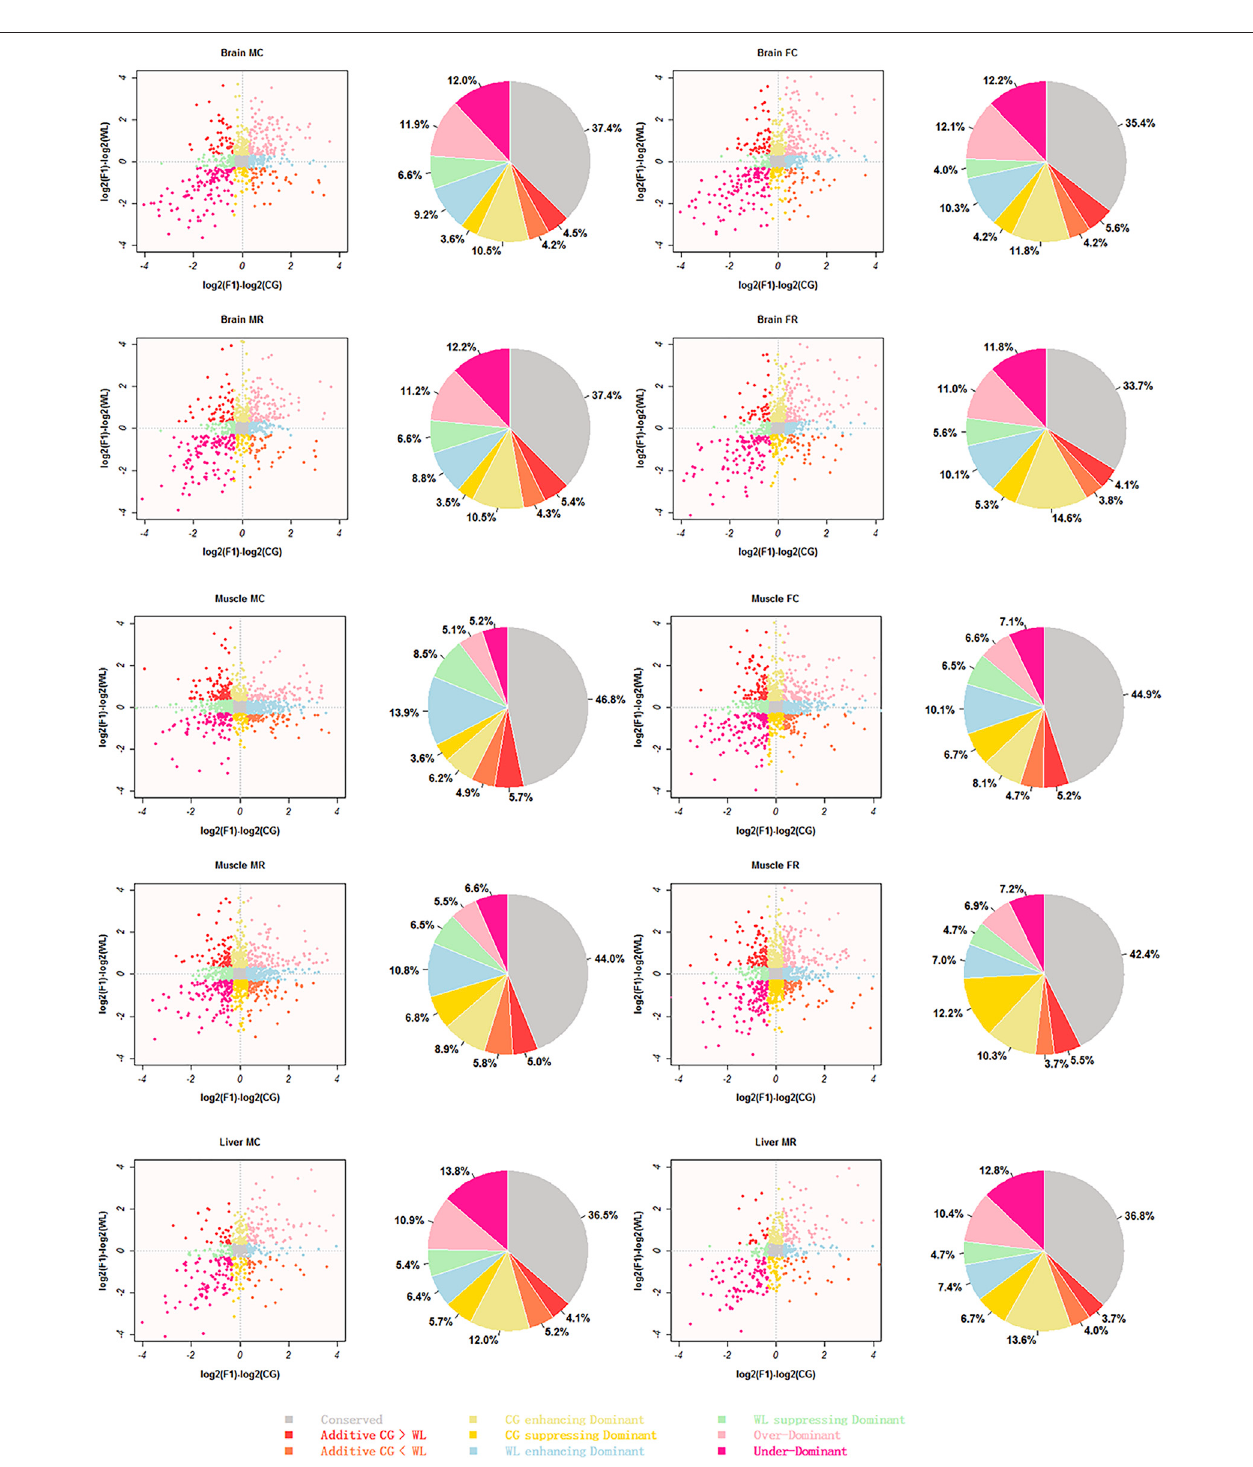
FIGURE6| Scatter-plotandpierepresentingdifferentinheritancepatterns. inheritancepatternsidenti fi edfromreciprocalcrossesandparentallinesbrain,muscle, and liver tissues were classi fi ed into nine clusters listed at the bottom of the images, respectively. Scatterplots represent relationships between F1 hybrids and their two parents, and pie charts show the relative proportions of these patterns for each cluster using different colors.